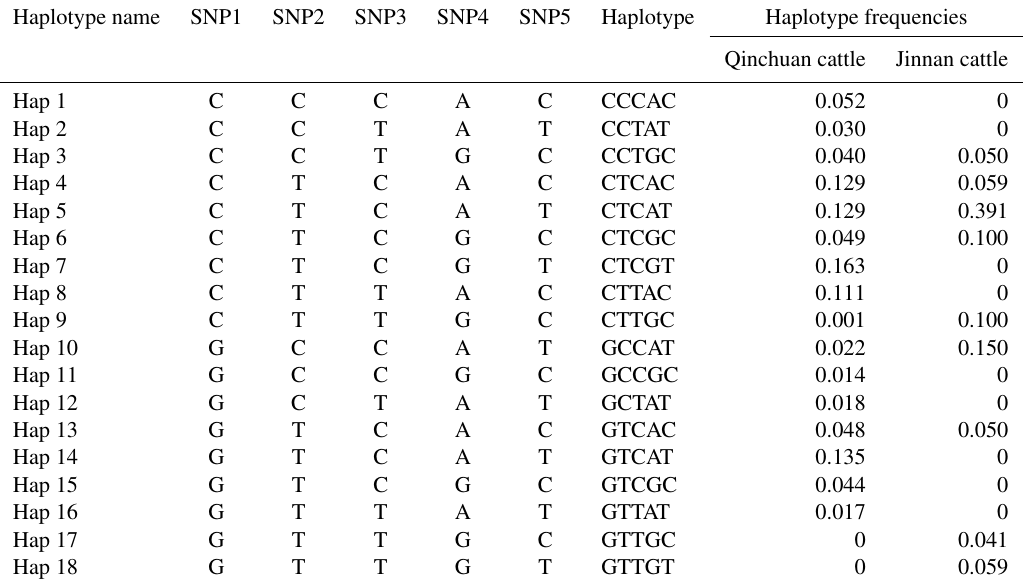
Table 4. Haplotype frequency within the ATBF1 gene in Qinchuan and Jinnan